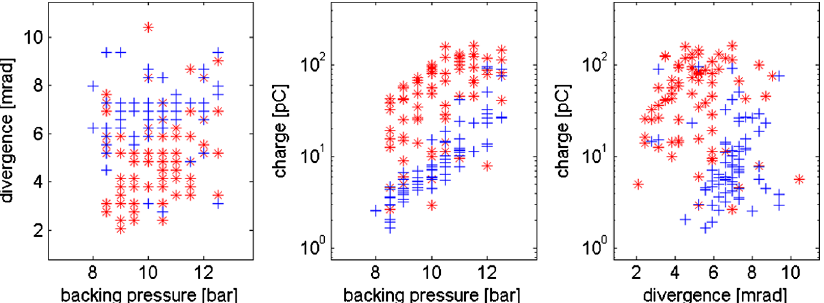
FIG. 2. Comparison of divergence and charge of electron beams using hydrogen as target gas. The red stars represent shots with the wire 0.5 mm below the laser axis, and blue crosses represent LWFA with nonlinear wave breaking and self-injection. Every data point corresponds to one shot. The failure rate with wire is below 5% and thus comparable to the wireless self-injection. Note the increased brightness indicated by the results in the figure to the right.